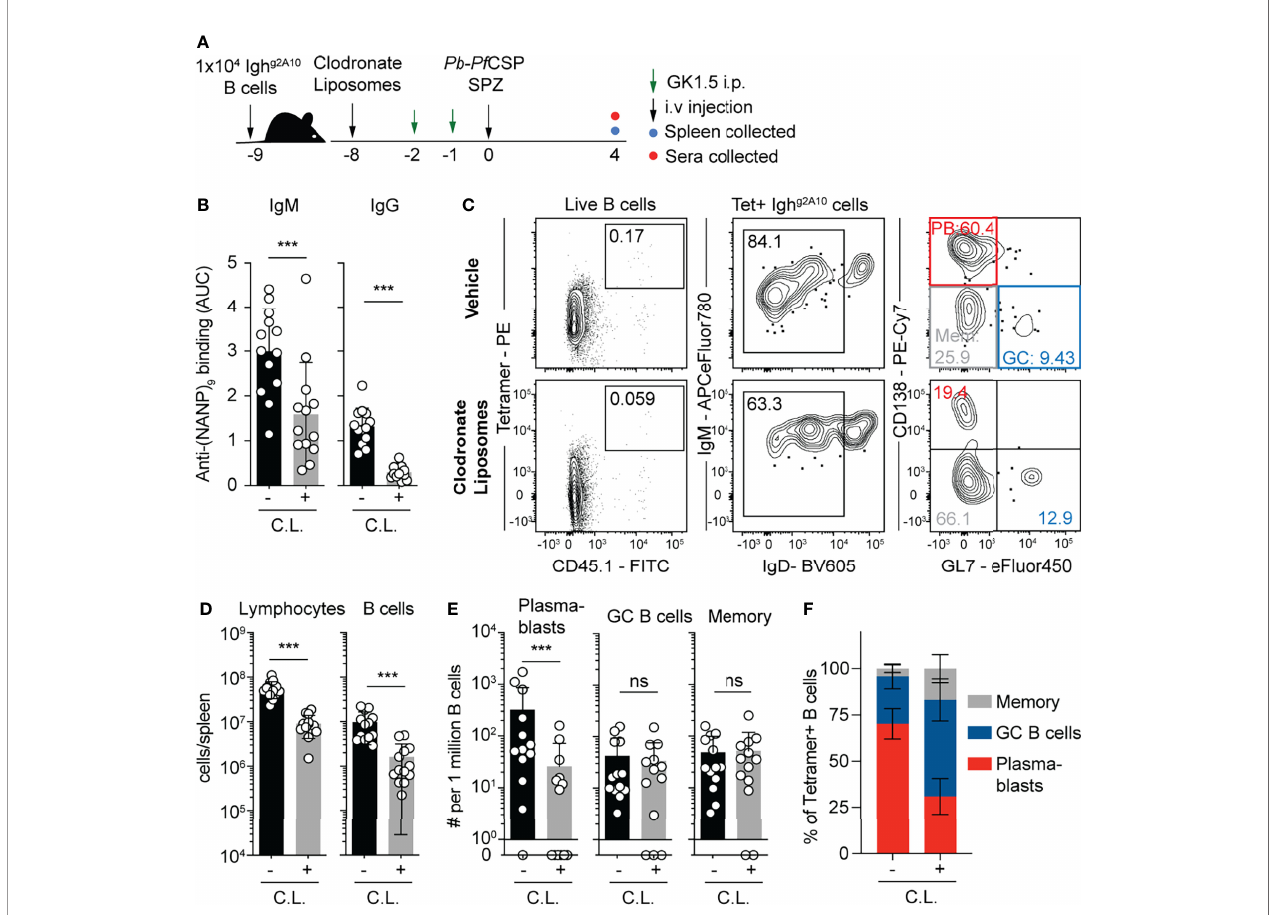
FIGURE 7 | Depletion of macrophages suppresses the plasmablast response 1x10 4 Igh g2A10 cells were transferred to mice prior to treatment with clodronate liposomes or vehicle alone 8 days prior to immunization with 5x10 4 Pb-Pf CSP SPZ. All mice received two doses of CD4 depleting antibody (GK1.5) in the 2 days prior to immunization. Antibody and B cell responses were assessed on day 4 post immunization. (A) Schematic of experimental strategy. (B) Serum titres of anti- Pf CSP antibodies at day 4 post-immunization, quanti fi ed by ELISA and presented as area under the curve (AUC). (C) Representative fl ow cytometry plots for the gating of Igh g2A10 B cells at 4 days post-immunization. Plots are pre-gated upon singlets, Dump-negative and B cells [CD19 + ± CD138 + ]. (D) Quanti fi cation of total lymphocytes and B cells in the different treatment groups. (E) Quanti fi cation of responding Igh g2A10 B cells of the plasmablast (PB), germinal centre (GC) and memory phenotype. (F) The proportion of each B cell phenotype as a percentage of the total Igh g2A10 population. Data from three independent experiments, with 3-4 mice per group. Statistical analysis performed by linear mixed model, with different experiments accounted for as a blocking factor for random effects. Abbreviations for p values are: ns, not signi fi cant; p < 0.001